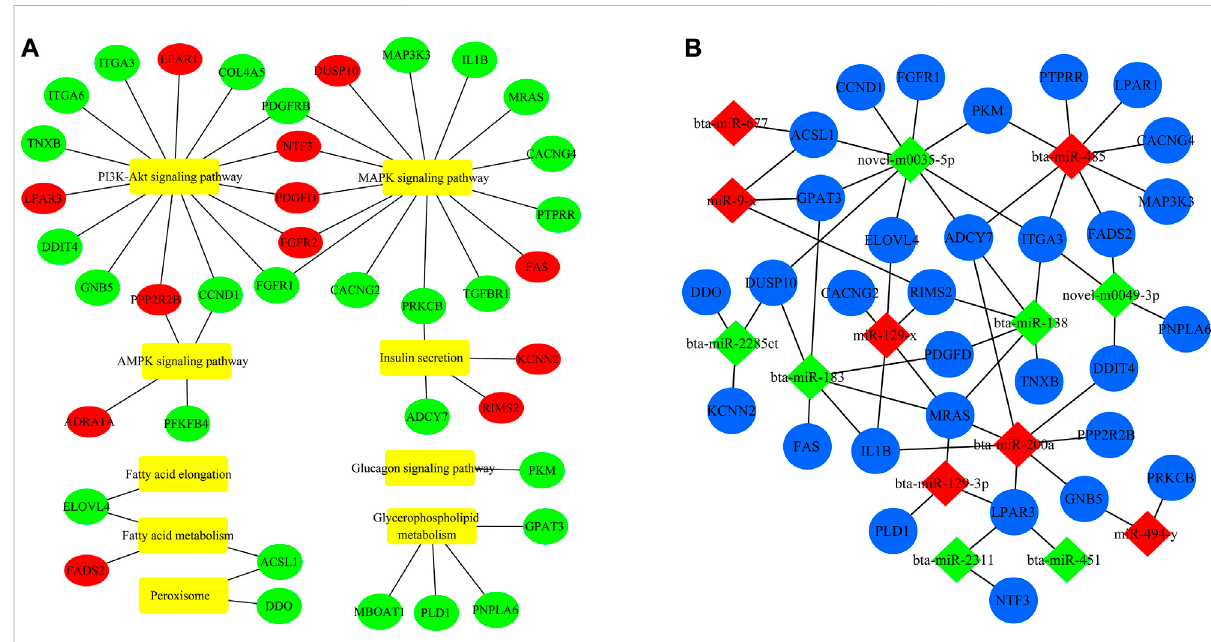
FIGURE 5 InteractionnetworkofDE-miRNAs. (A) NetworkanalysisofDE-miRNAtargetgenesandtheirenrichmentpathways.Redshowstheupregulated mRNA. Green represents downregulated mRNA, and yellow represents the enriched signaling pathways. (B) Co-expression network of DE-miRNA and its target genes. Red is the miRNA whose expression is upregulated. Green represents downregulated miRNA, and blue represents